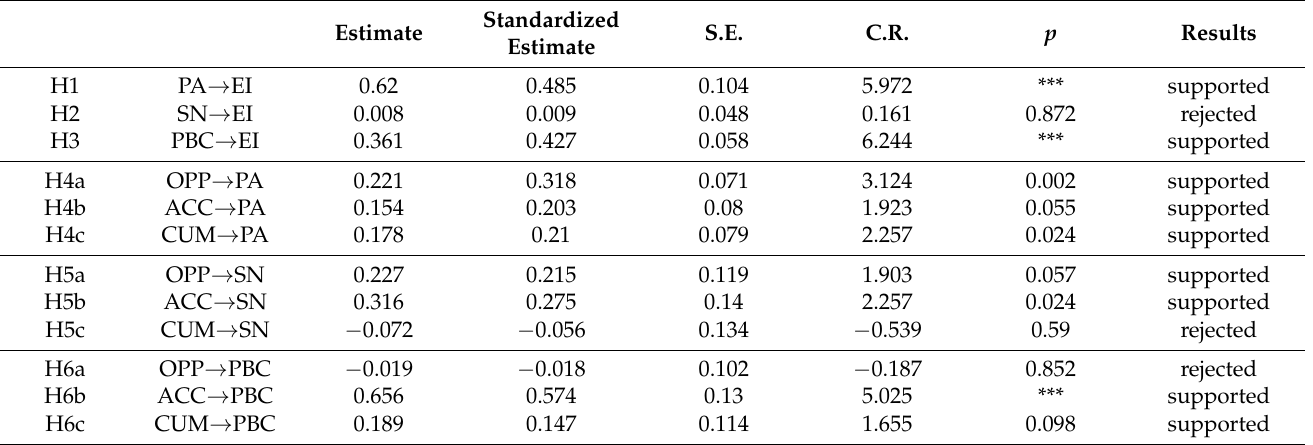
Figure 1. SEM results. Values are standardized estimates, *** p < 0.000, ** p < 0.05, and * p < 0.1, (model fit) χ 2 = 643.939 (df = 309), p = 0.000, normed χ 2 /df = 2.084, GFI = 0.814, CFI = 0.915, IFI = 0.915, and TLI = 0.903. Table 5. Hypotheses